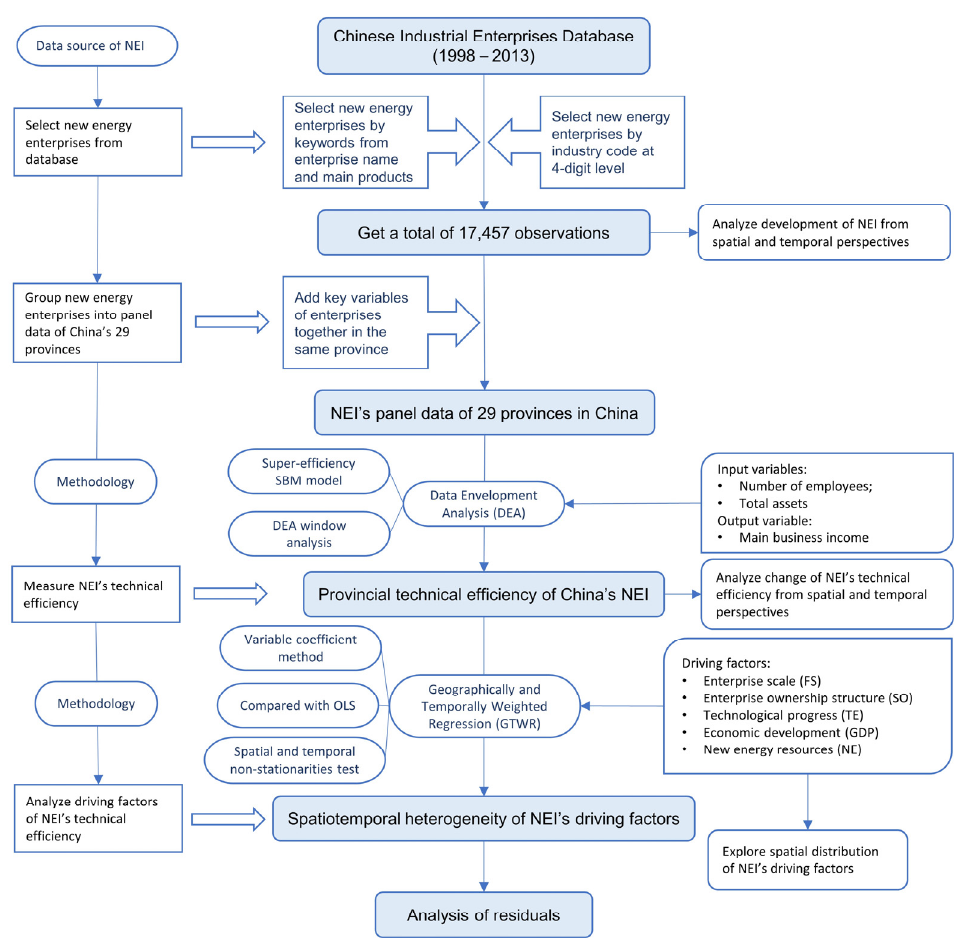
Figure 1. Overall research methodology of this